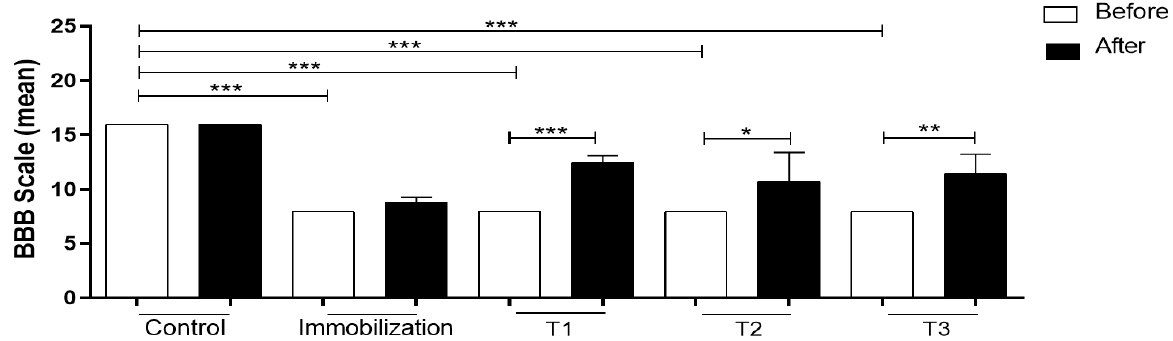
Figure 4. Basso Beattie and Bresnahan (BBB) score of experimental animals performed between and within groups in the period before and after 30 days of using EOAz. Where T1 (treatment 1), T2 (treatment 2) and T3 (treatment 3). The data were expressed as mean ± standard deviation. ANOVA One-Way test with Tukey post-test, with * p <0.05; ** p <0.01; *** p <0.001.